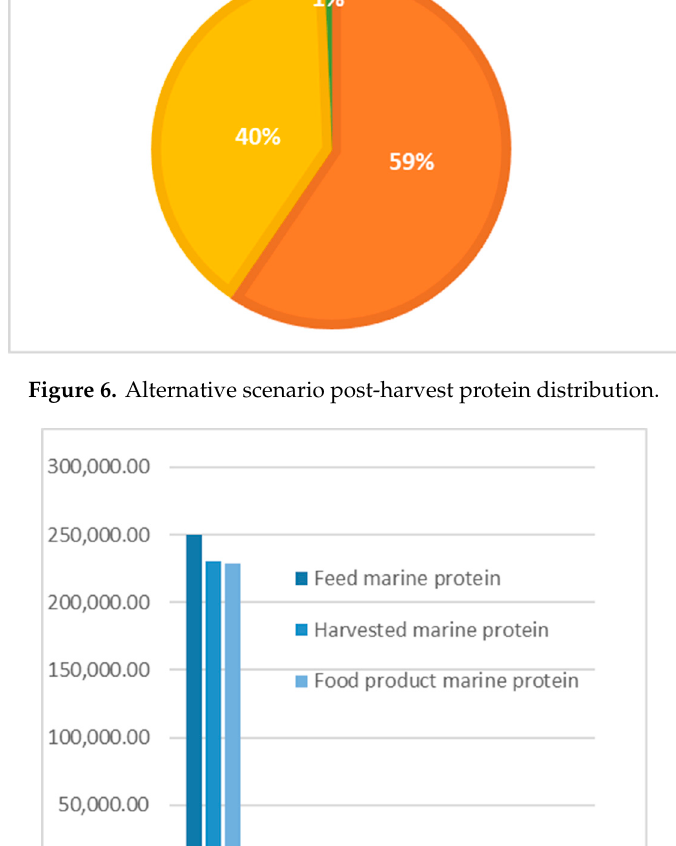
Figure 7. Alternative scenario marine protein quantities.